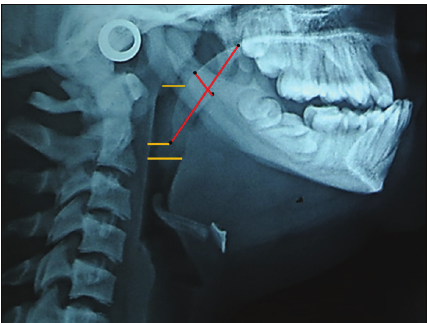
Figure 6: Soft palate and airway